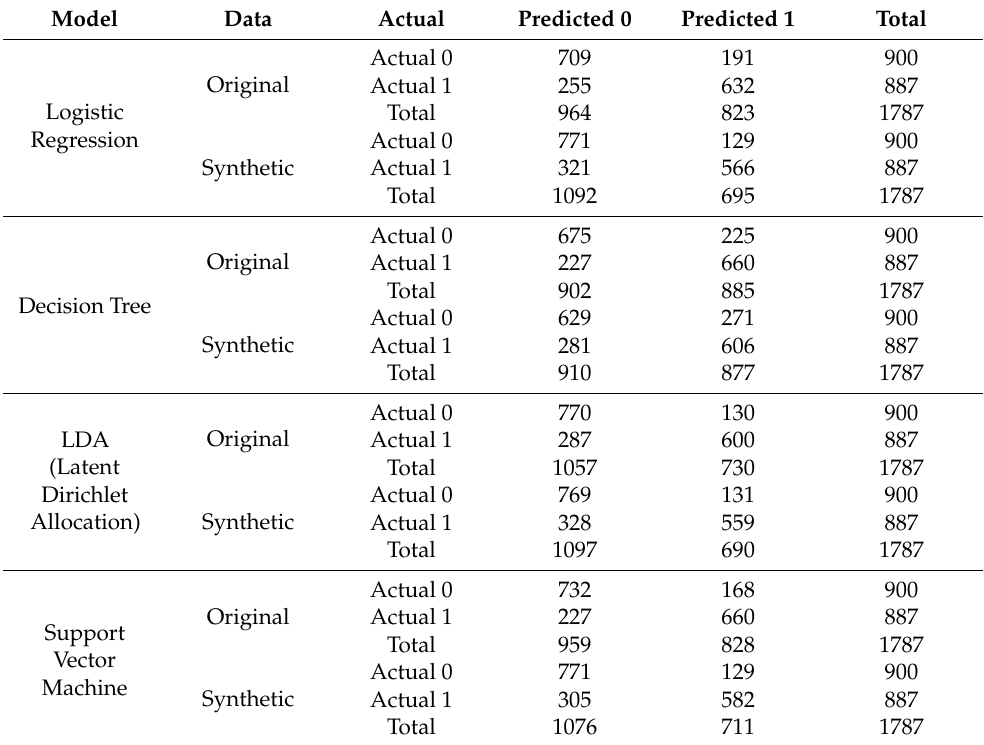
Table 4. Confusion matrices for original and synthetic